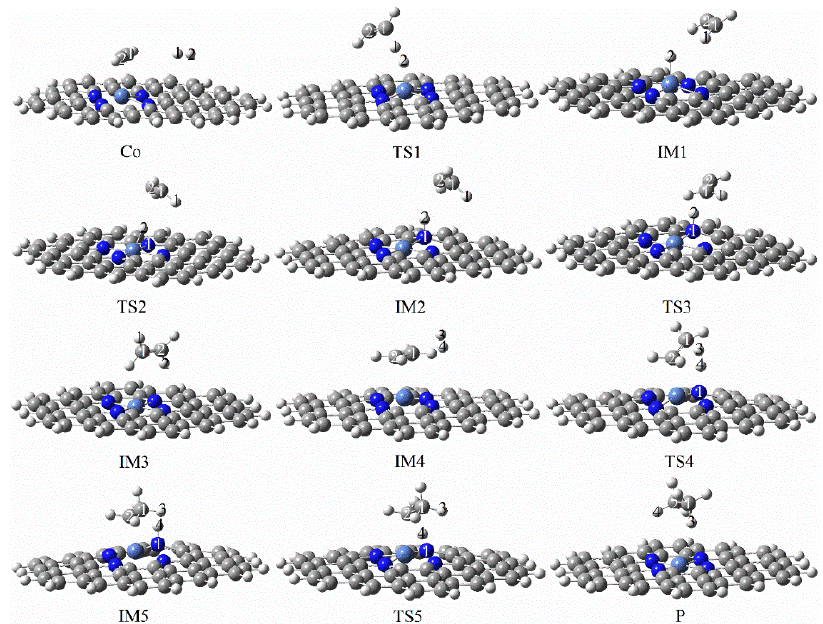
Figure 15. Optimal reaction pathway for acetylene hydrogenation catalyzed by graphene-NiN 4 catalyst.